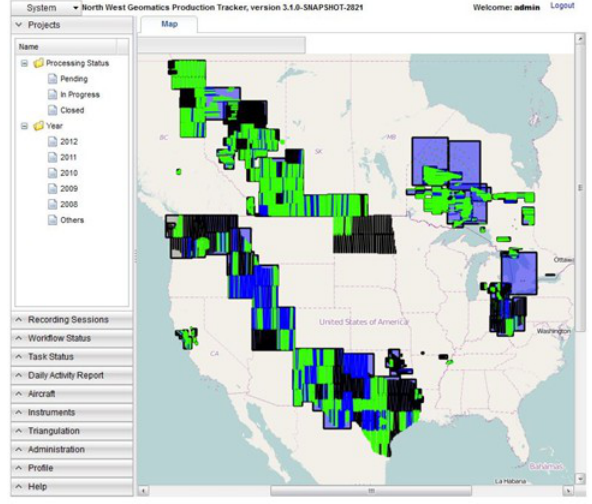
Figure 3: Overview of acquisition blocks in Production